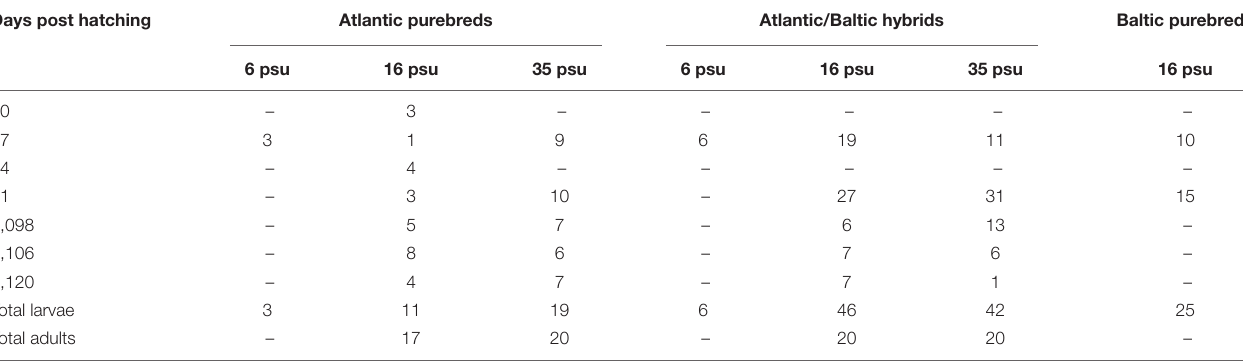
TABLE 2 | Overview of number of F1 progeny larvae (50–71 days post hatching = DPH) and adults (1098-1120 DPH) used for otolith microstructure analysis from various sampling dates and different salinities. Days post